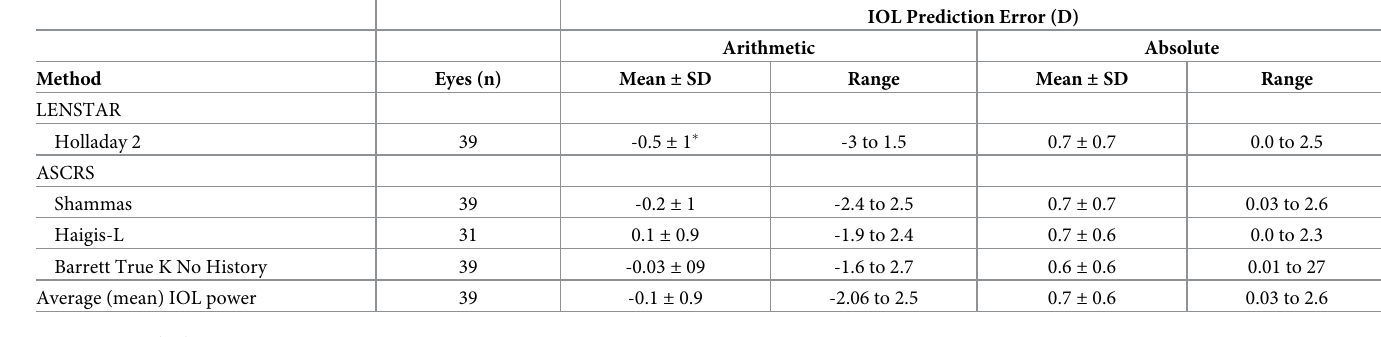
Table 3. Mean arithmetic and absolute IOL prediction error using Holladay 2 and no prior data methods from ASCRS IOL calculator (implanted IOL power—pre- dicted IOL power). A positive value indicates that a lower power than the power implanted was predicted and that would result in post-operative hyperopia.